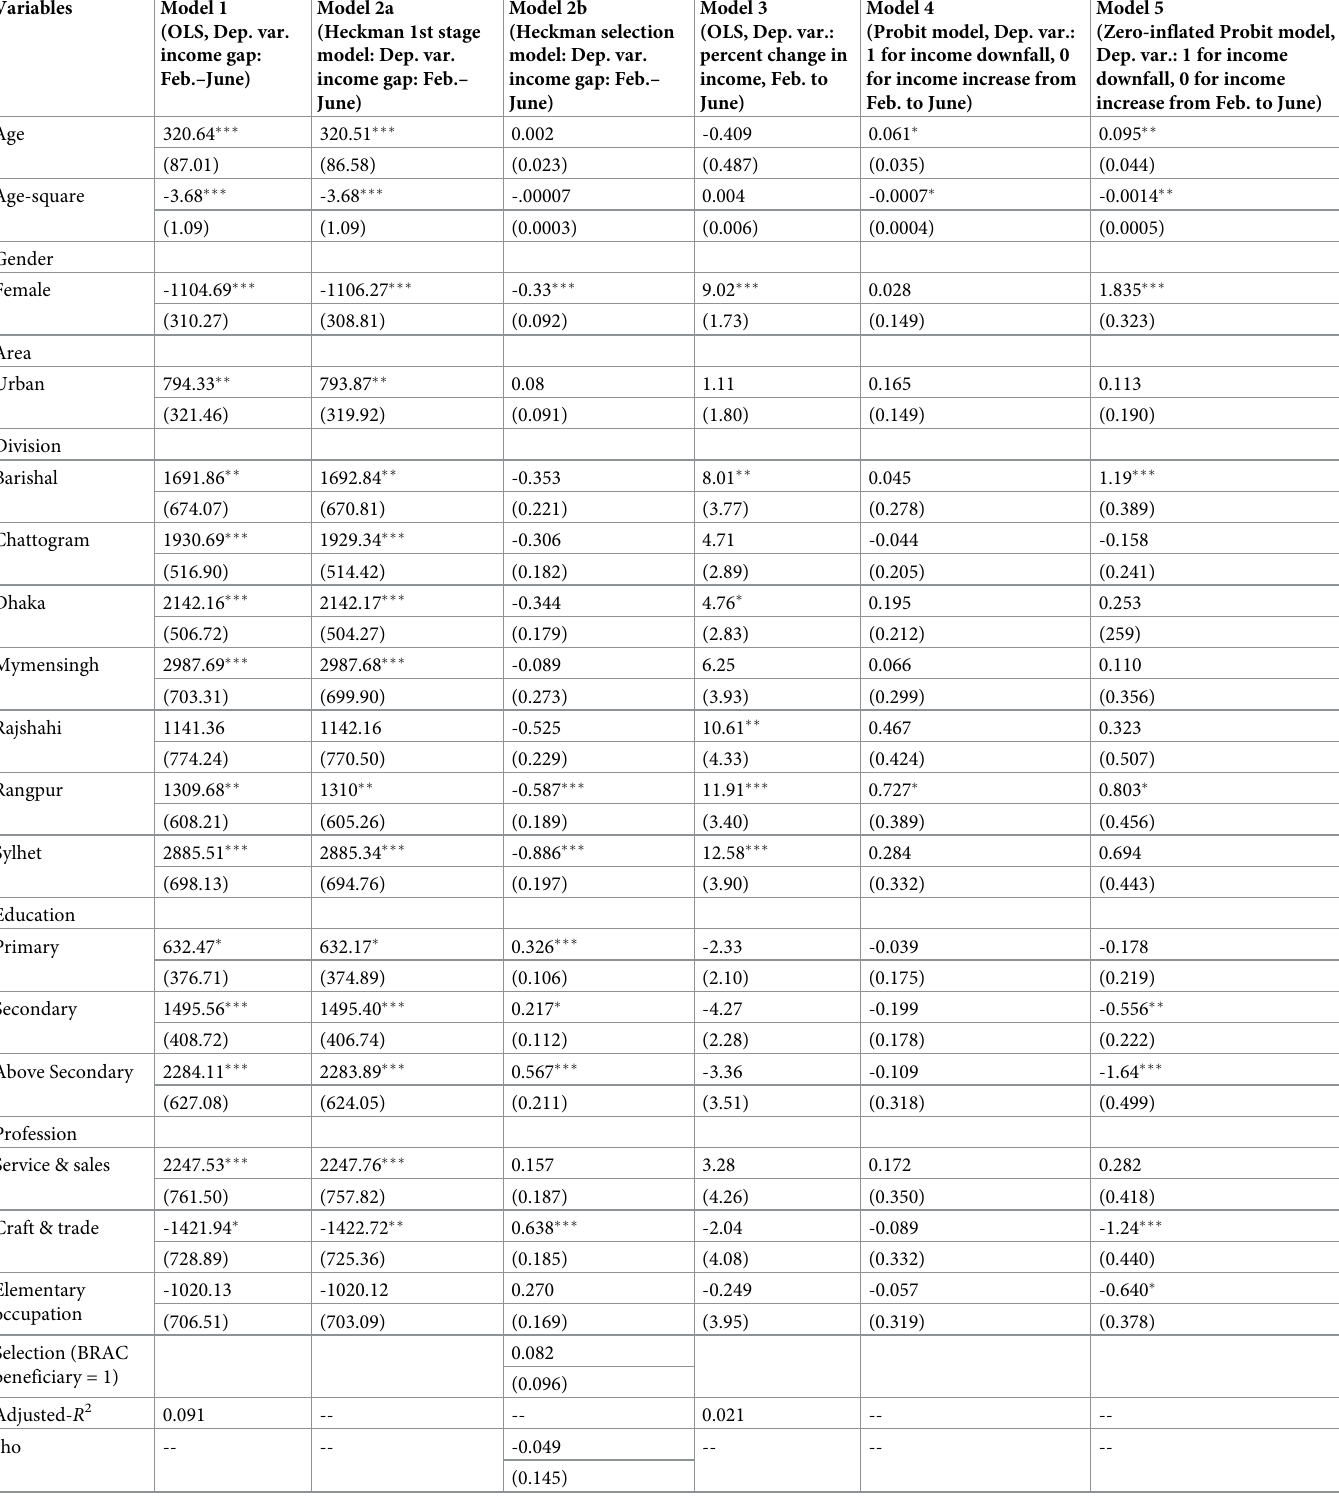
Table 6. Multivariate regression analysis and determinants of income